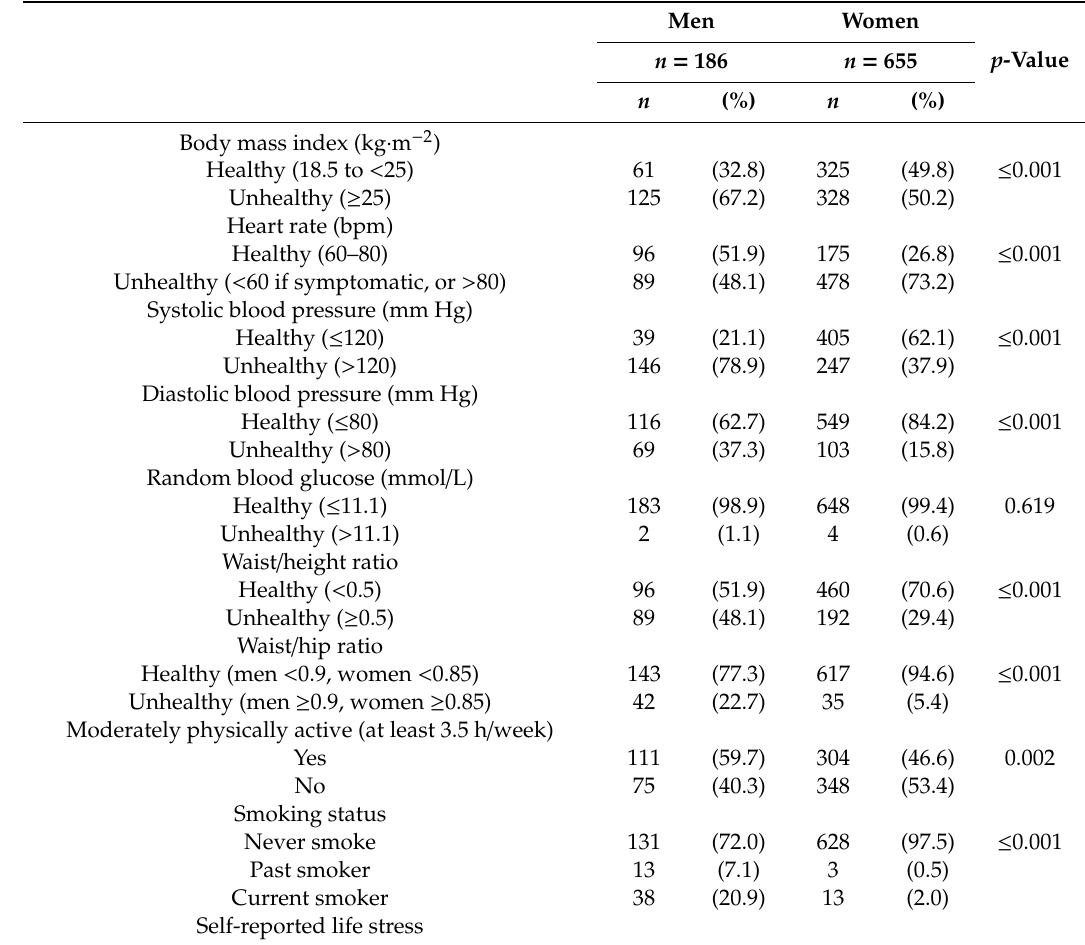
Table 3. Objective and behavioral characteristics of males vs.